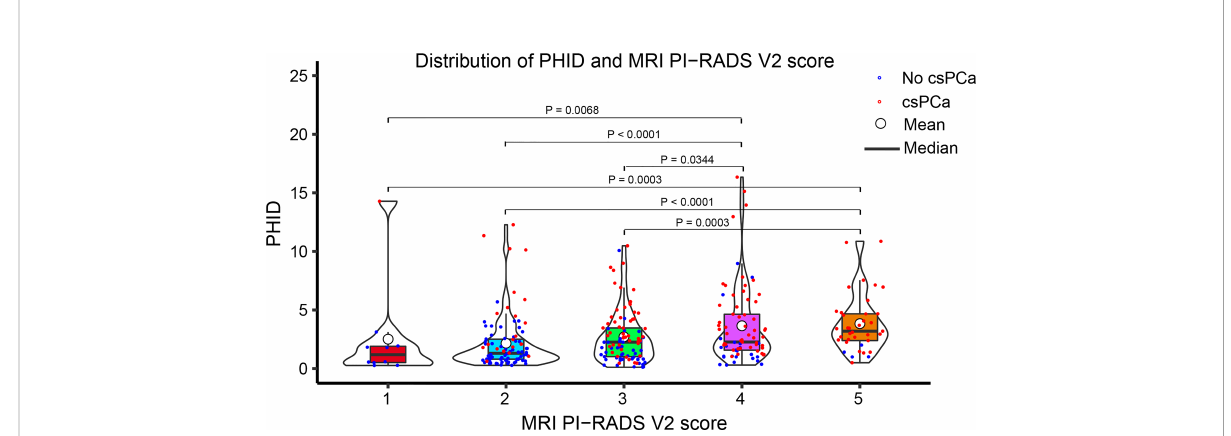
FIGURE 2 Violin plot showing the distribution of PHID according to the PI-RADS v2 score. Data are shown as the median (bold horizontal line in the box) and Q1 and Q3 (borders of the box). Q1 = 25th percentile; Q3 = 75th percentile; IQR (interquartile range) = Q3-Q1.